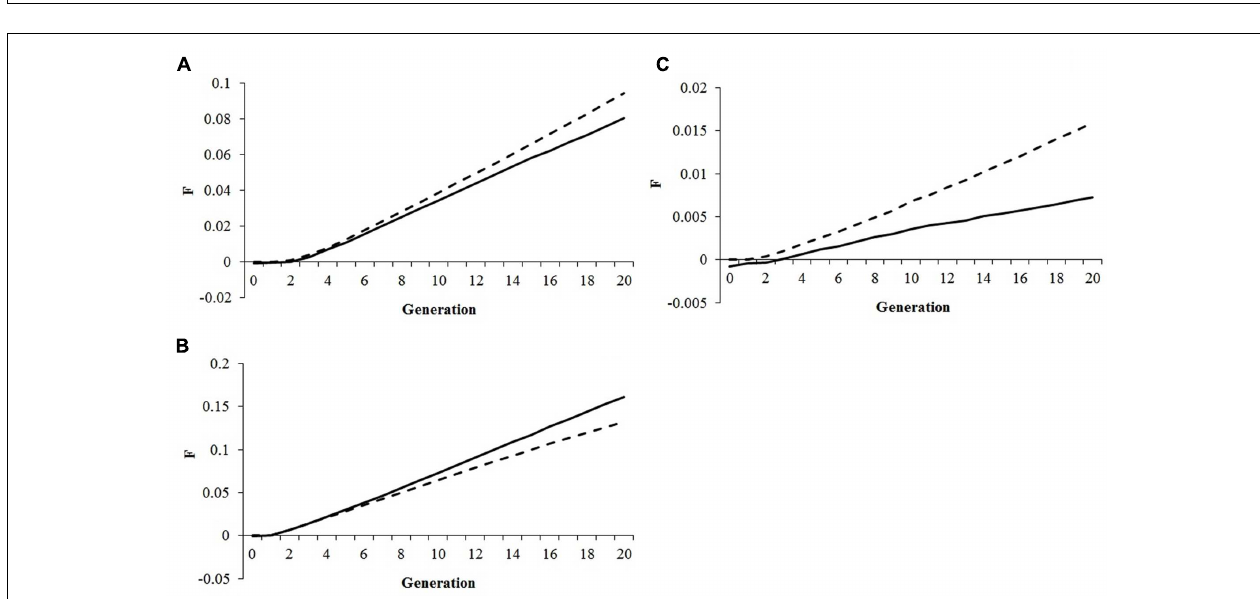
FIGURE 1 | Effect of mating strategy. Pedigree inbreeding (A) and genomic inbreeding (B) in an optimal contribution of both sexes strategy to maximize genetic gain followed by either random mating (solid line) or mating based on the minimum kinship principle (dashed line); selection index was 50%/50% productivity/fitness; genomic inbreeding constraint was 0.01.